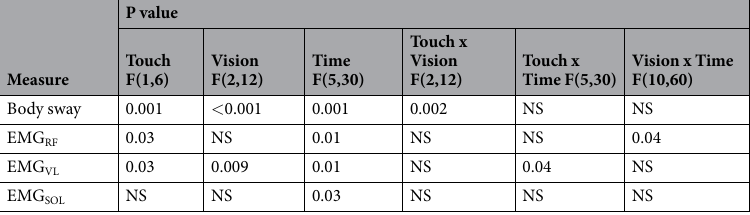
Table 2. GLM comparison of muscle activation and postural sway in the antero-posterior direction for post perturbation conditions. Body sway was measured at the level of the base of the neck (7 th cervicular vertebrae). NS: no significant difference. Three-way interactions were not studied due to the sample size.